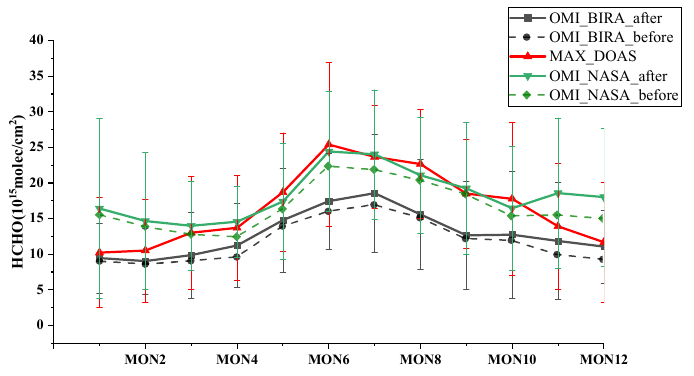
Figure 12. Before and after aerosol correction.